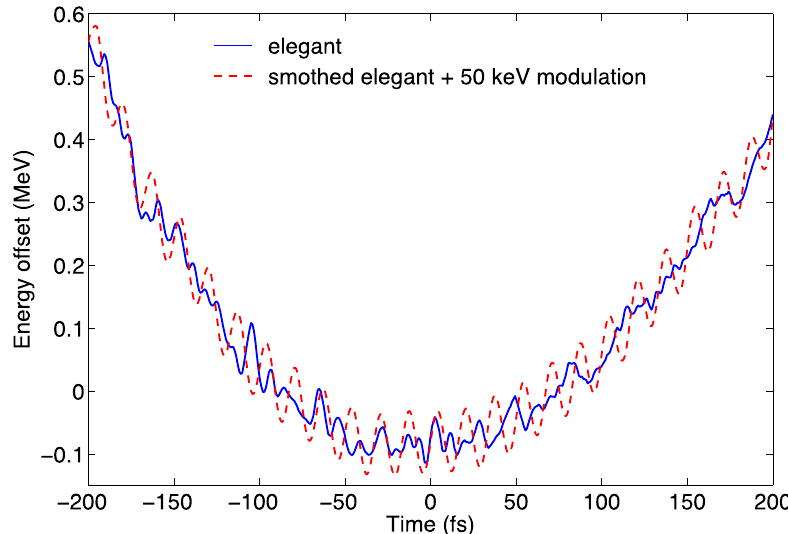
Figure 2. Two e-beam energy profiles used for FEL simulations. The energy offset is measured with respect to the nominal energy of 1.4 GeV.